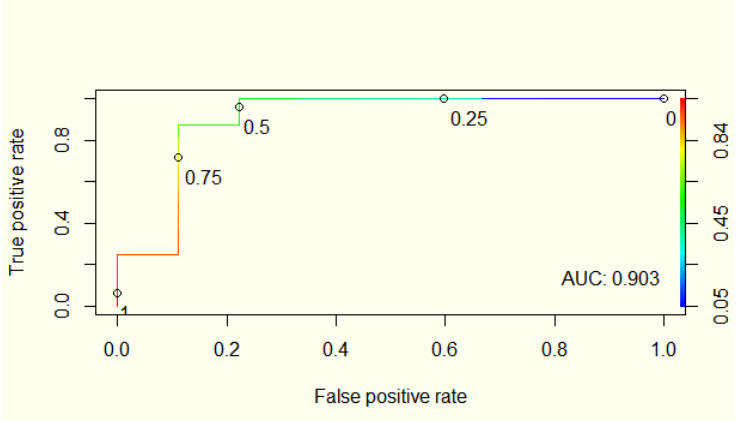
Figure 3. Logistic regression model for predicting UC disease activity based on magnesium, CRP (C reactive protein), and serum albumin level.